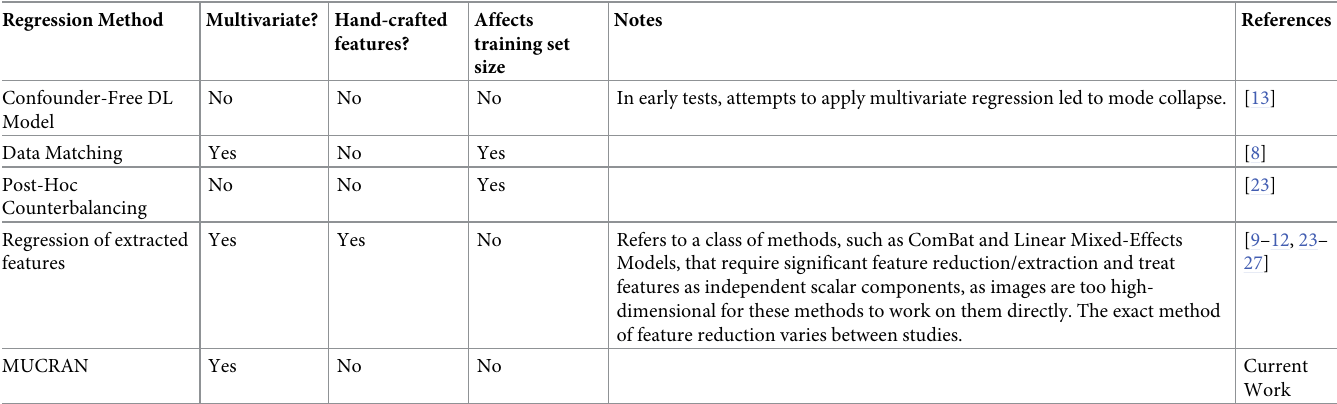
Table 3. Comparison of MUCRAN with other generalizable variable regression methods used in neuroimaging. Regression